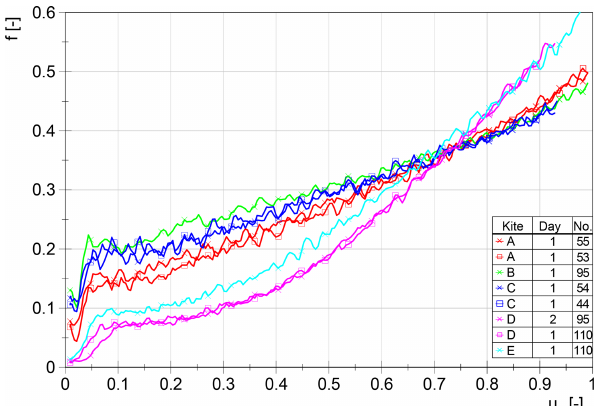
Figure 16. All measurement files: force ratio between steering lines and the power line.